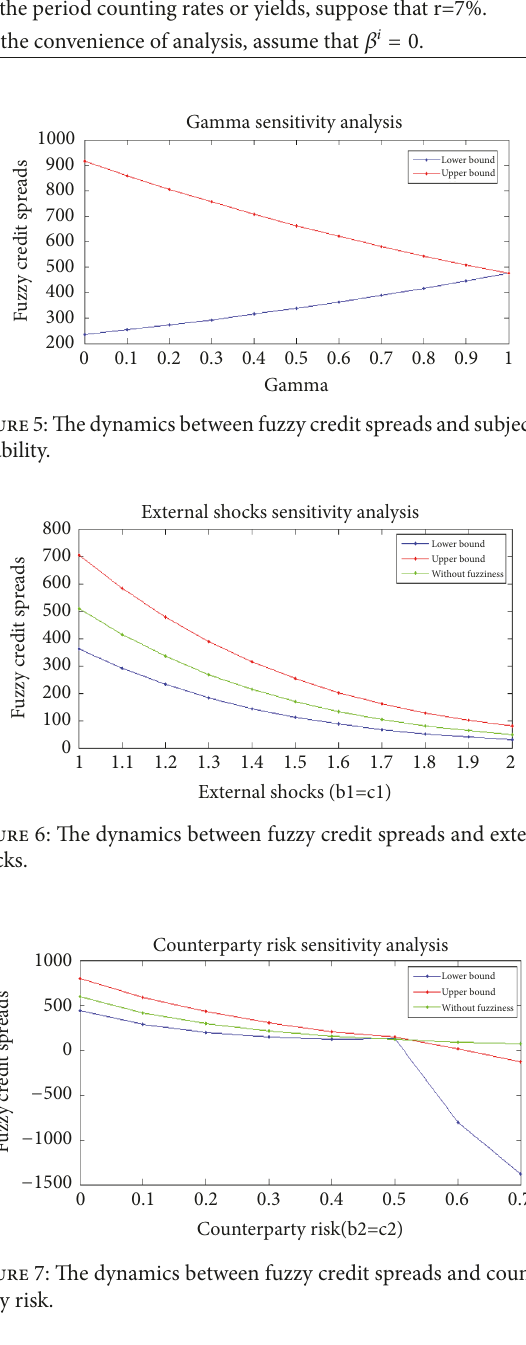
Figure 4: The dynamics between fuzzy credit spreads and fuzzy degree of interest rates.